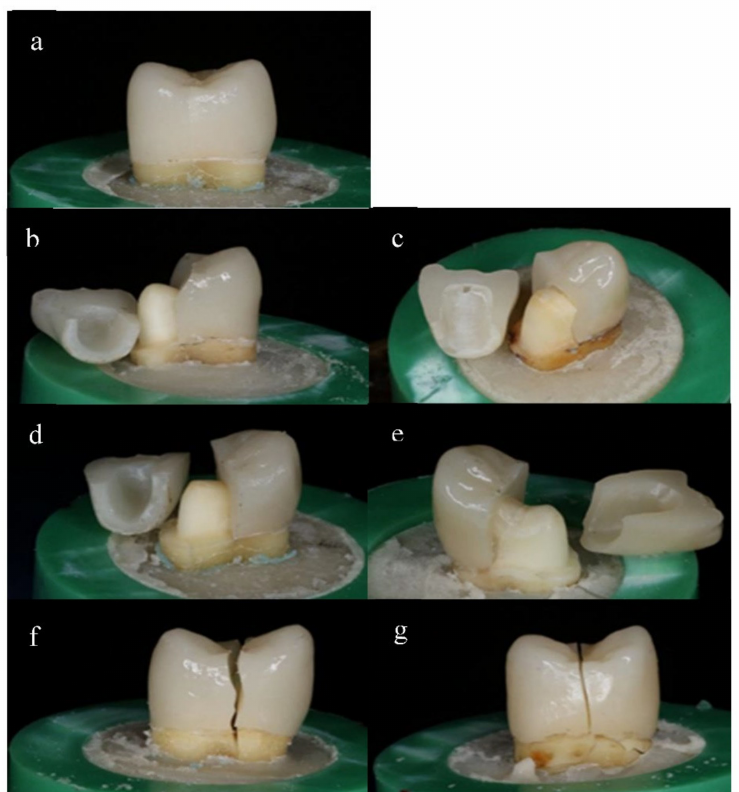
Figure 4. Stereomicroscopic images of the failure modes: ( a ) cracked lithium disilicate restoration cemented with Panavia SA at 25 ◦ C (Class I); ( b ) fractured lithium disilicate restoration cemented with LinkForce at 54 ◦ C (Class II); ( c ) fractured zirconia restoration cemented with Panavia SA at 25 ◦ C (class II); ( d ) fractured lithium disilicate restoration cemented with Panavia SA at 25 ◦ C (Class III); ( e ) fractured zirconia restoration cemented with Panavia SA at 54 ◦ C (class III); ( f ) severe facture involving the lithium disilicate restoration and the tooth (class IV); ( g ) severe facture involving the zirconia restoration and the tooth (class